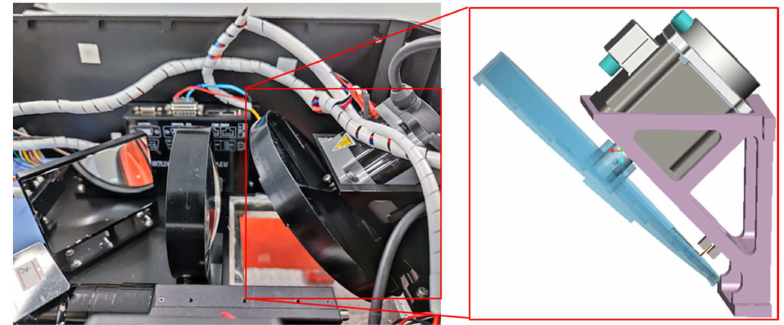
Figure 5. Implementation of a scanning optical